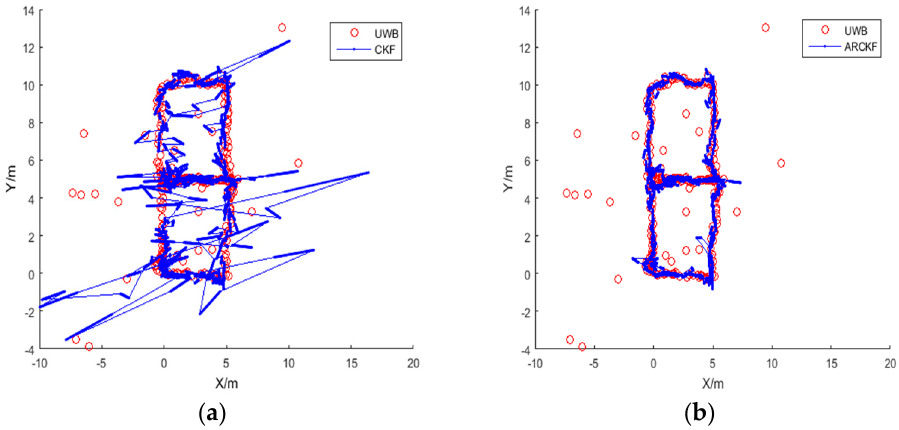
Figure 17. Positioning result for Route 2: ( a ) the standard CKF; ( b ) the proposed ARCKF.